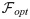
Cortical task switching enhances discrimination.(A) The training stimuli consisted of 2 pairs of dissimilar stimuli. (B,C) Resulting bulbar and cortico-bulbar connectivity. (D) The probe stimuli consisted of two mixtures of the training stimuli. (E) Cortical connectivities after cortical training on the individual components (left) and on the mixtures (right). (F) MC activities with cortex trained on the components (left) and on the mixtures (right), respectively. After training on the mixtures the inhibition by the top-down input reduces the MC amplitudes without reducing the difference between the two mixtures, enhancing their discriminability. (G) Optimal Fisher discriminant Fopt with cortex trained on the components (blue) and on the mixture (green). The error bars reflect the ongoing network fluctuations.